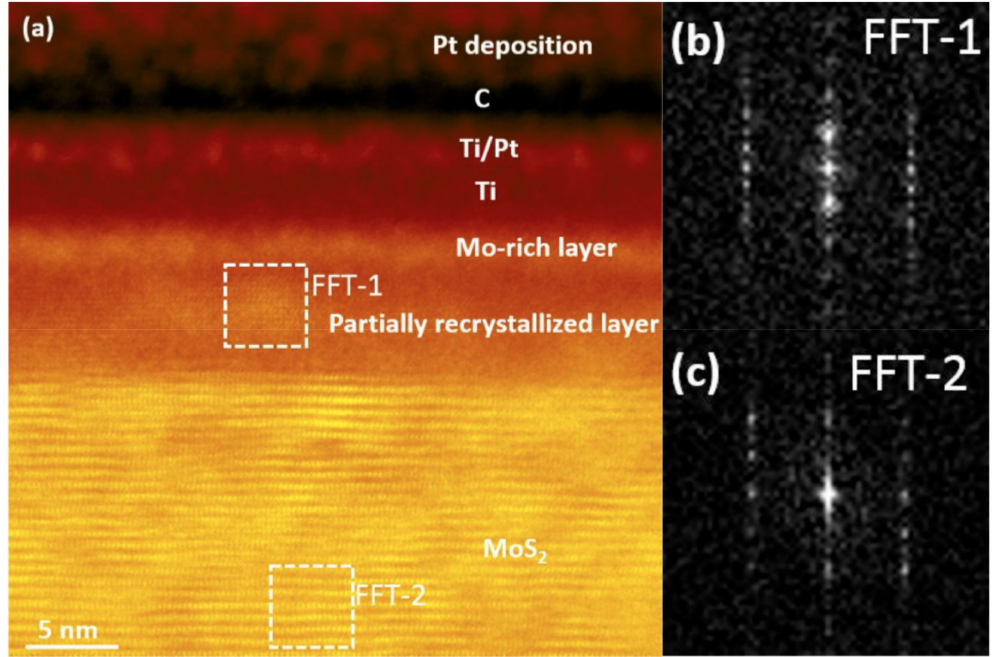
Figure 7. ( a ) Cross-sectional ADF-STEM image of Ti–MoS 2 after 30 min anneal at 400 ◦ C showing a Mo-rich layer and a partially recrystallized layer grown out from the disordered Mo / S-rich layer, ( b ) and ( c ) are FFT images of the white dotted-line framed regions in (a). Reprinted with permission from Freedy et al. ACS Appl. Mater. Inter. 11(38) 35389, (2019). Copyright (2019) American Chemical